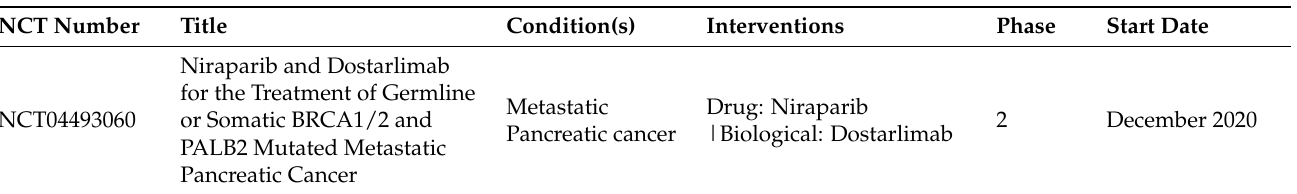
Table 1. Selection of interventional clinical trials for PDAC patients with germline mutations is currently